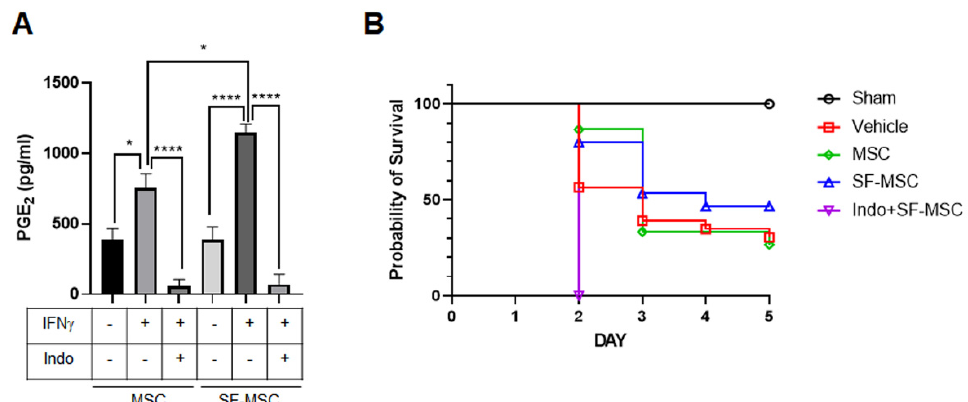
Figure 5. Inhibiting PGE 2 secretion completely fails to save mice from septic damage. ( A ) Secreted human PGE 2 in an MSC culture medium was determined using the ELISA. MSCs on each surface were treated with 100 ng/mL of IFN- γ for 24 h. 100 μ M of indomethacin (marked as Indo) was treated with IFN- γ at the same time ( n = 4 independent experiment; one-way ANOVA, * p < 0.05, and **** p < 0.0001). Error bars represent ± S.E.M. ( B ) At 6 h after sepsis was induced, MSCs for each condition were injected through the tail vein. Mice were assessed every day for up to 5 days. Percent survival was determined for each group and presented in the Kaplan–Meier format. ( n =